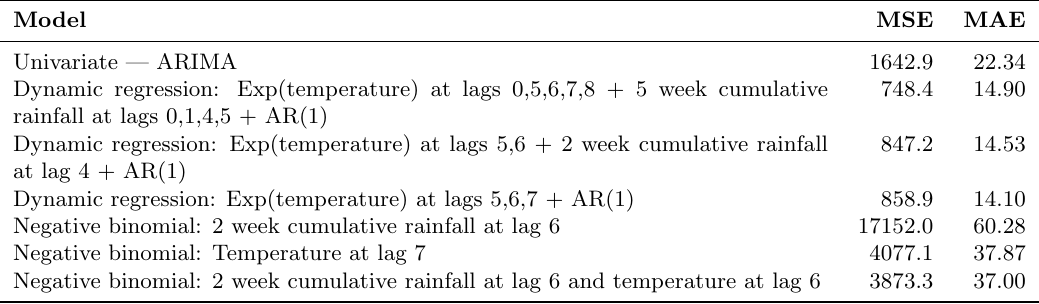
Table 1: Comparative goodness of fit statistics for models (lower values are better).